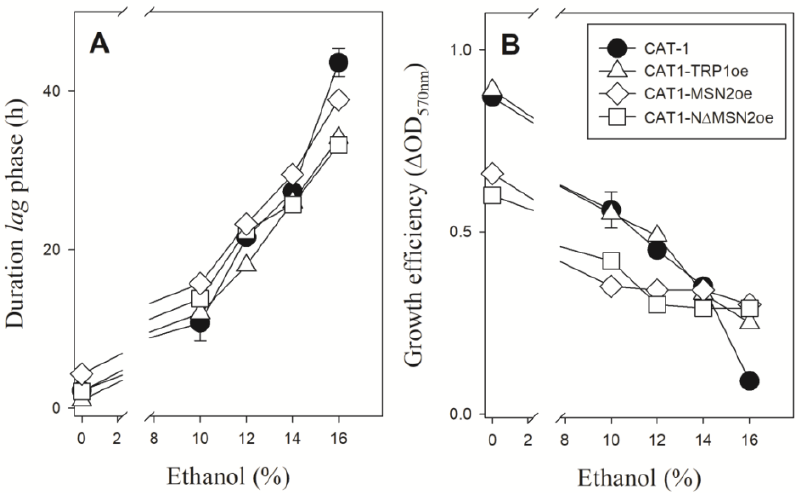
Figure 2. Fitness components (( A ), duration of the lag phase, and ( B ), growth efficiency) affected by the presence of the indicated concentrations of ethanol during growth in YP-20 g/L sucrose by the industrial fuel ethanol strain CAT-1, and the recombinant strains CAT1-TRP1oe, CAT1-MSN2oe, and CAT1- NΔMSN2oe.